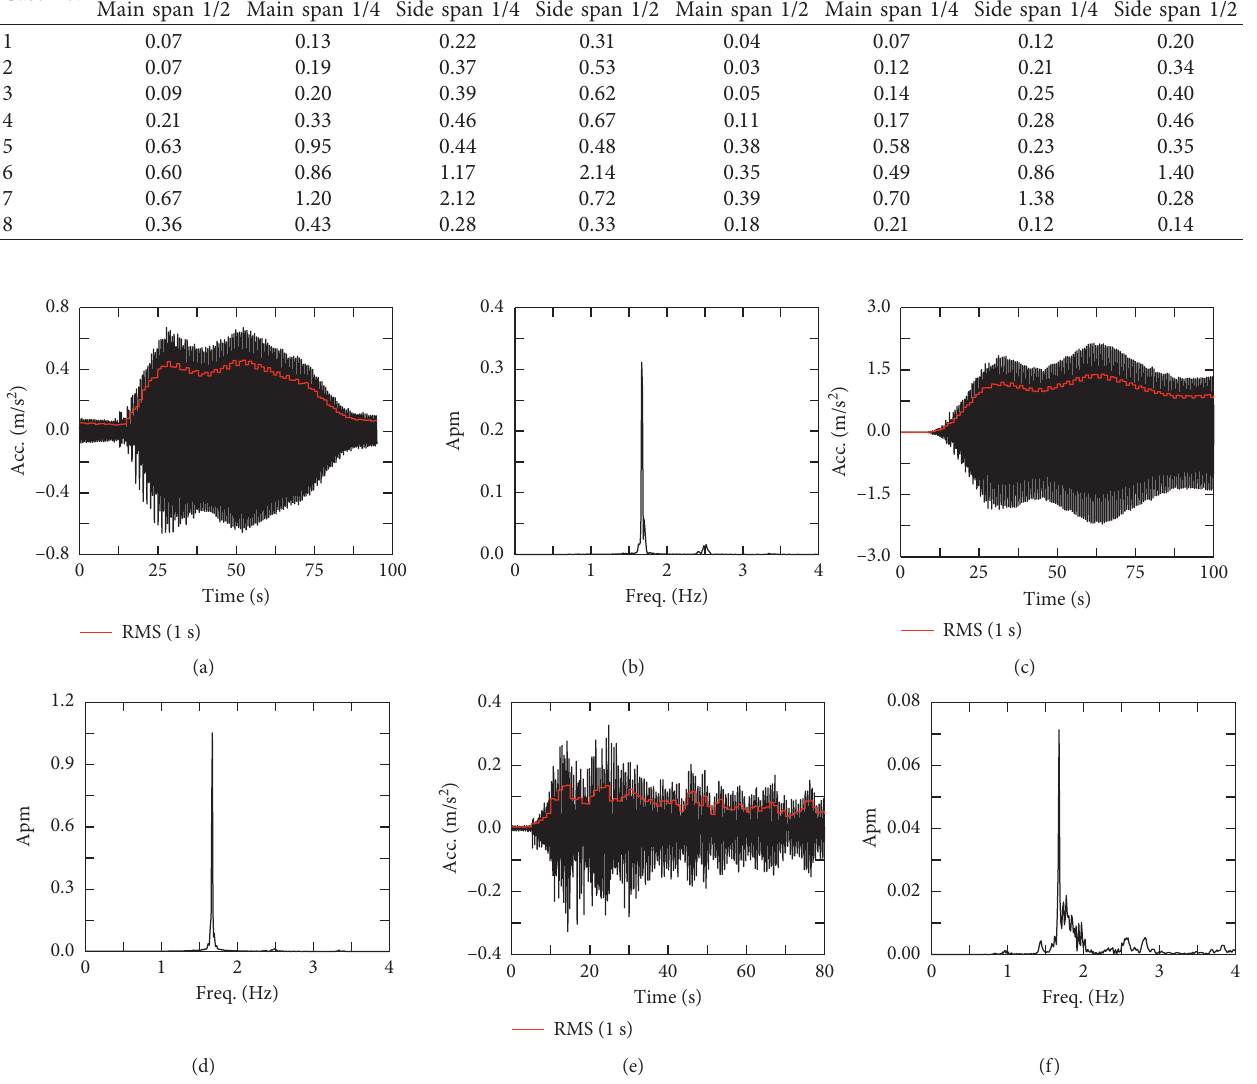
Figure 11: Measured bridge acceleration at TP12 (center of side span) in both time and frequency domains. (a) S4 walking at 1.67Hz, time domain. (b) S4 walking at 1.67Hz, frequency domain. (c) Group (7 × 1) walking at 1.67 Hz, time domain. (d) Group (7 × 1) walking at 1.67Hz, frequency domain. (e) Random walking (7 × 1), time domain. (f) Random walking (7 × 1), frequency